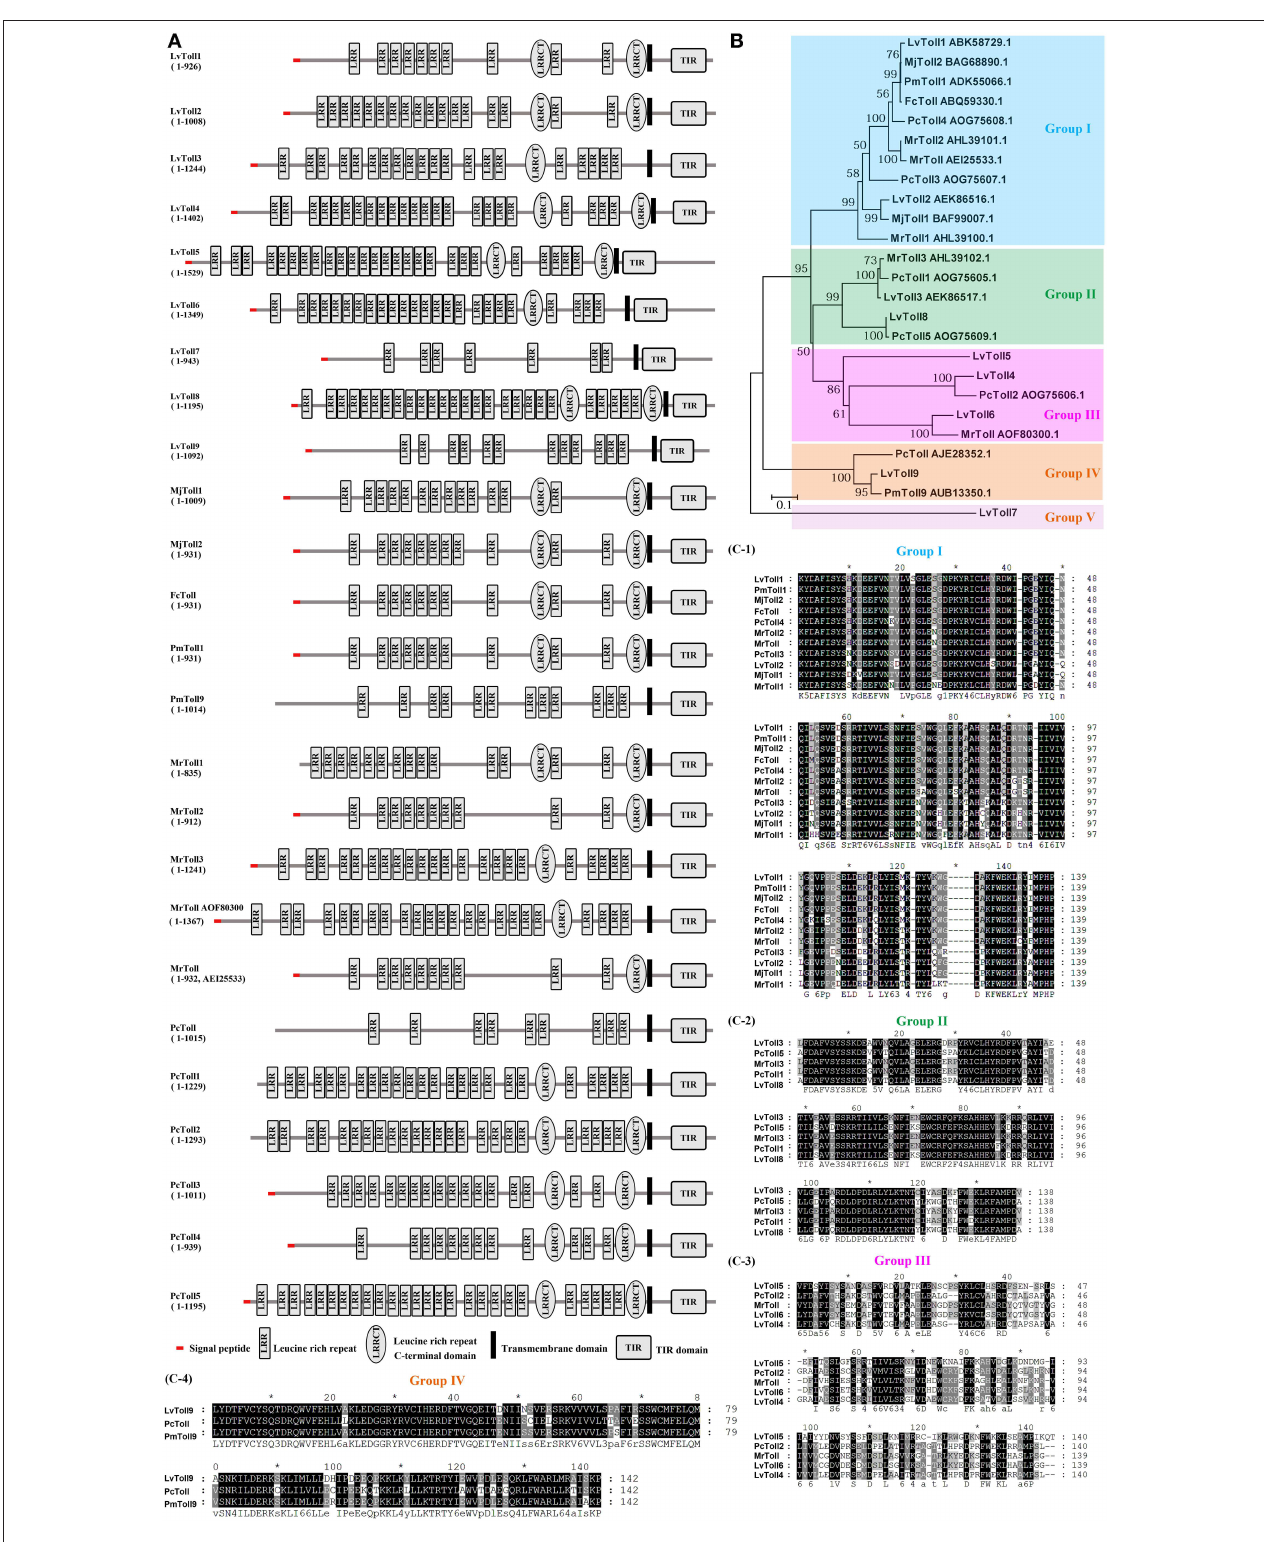
FIGURE 1 | Tolls identified from shrimp. (A) Architectural representation of characteristic domains of 25 Tolls from six different shrimp species. (B) Phylogenetic-tree analyses of TIR domains of the Tolls. Genbank accession numbers of some Tolls are shown after their scientific names. (C) Multiple sequence alignments of shrimp Toll proteins from Group I (C-1), Group II (C-2), Group III (C-3), and Group IV (C-4).